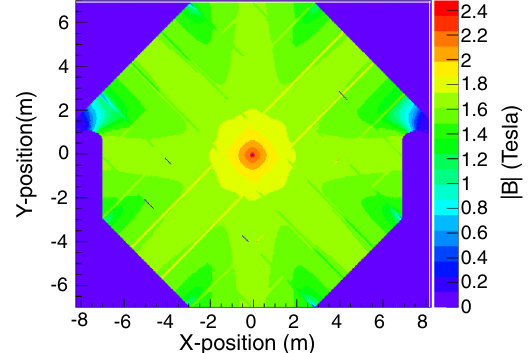
FIG. 3. The magnetic field in iron simulated from the finite element studies of the MIND plate assuming an STL current of 100 kA.